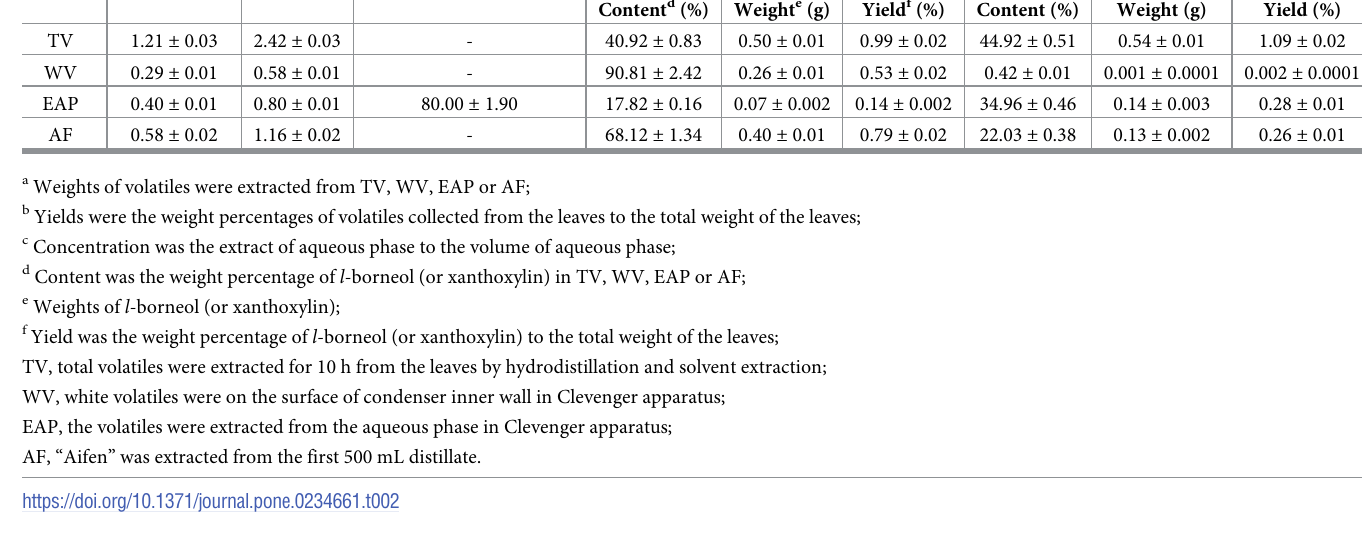
Table 2. Yields of l -borneol and xanthoxylin in the different volatiles from the leaves of Luodian Blumea balsamifera . Extracts Volatiles a (g) Yield b (%) Concentration c (mg/mL) l